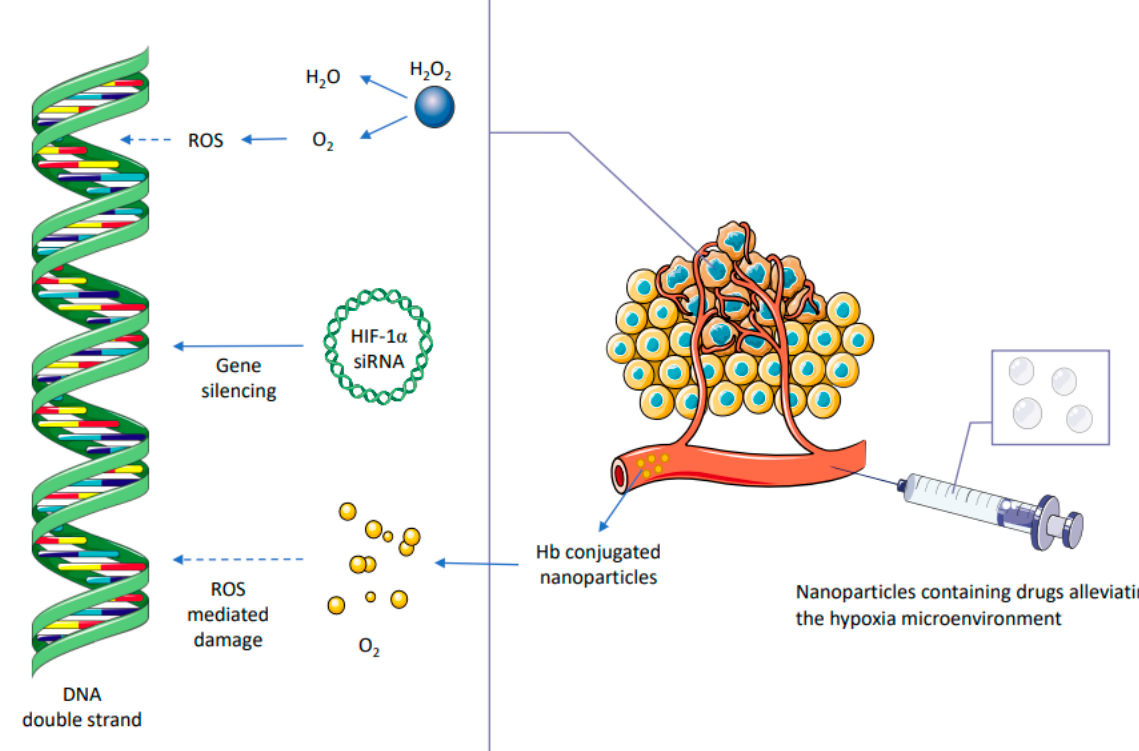
Figure 2. The implications of nanoparticles containing radiosensitizing drug moieties for alleviating tumor hypoxia. For instance, Hb-conjugated nanoparticles could induce ROS-mediated DNA damage through enhancing oxygen tension. In addition, HIF-1 α expression could be downregulated using siRNA-mediated gene silencing using nanocarriers during radiotherapy or brachytherapy, which subsequently fosters radiosensitization.